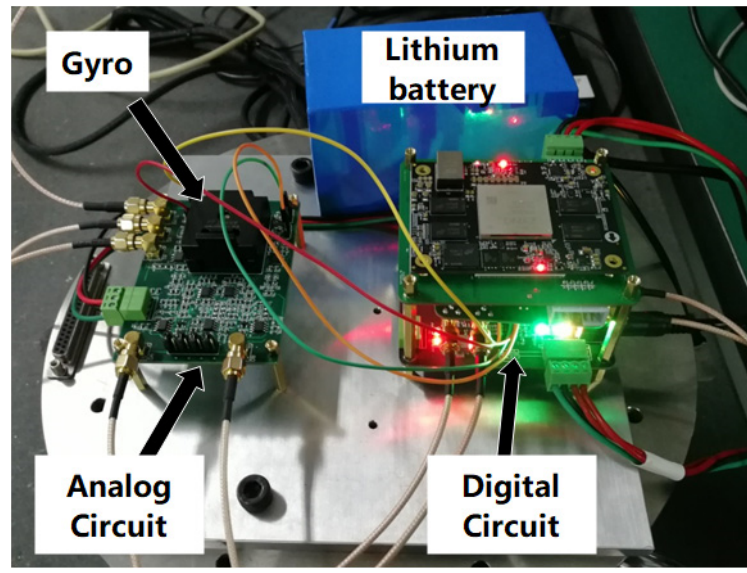
Figure 9. The photo of the gyroscope circuit.